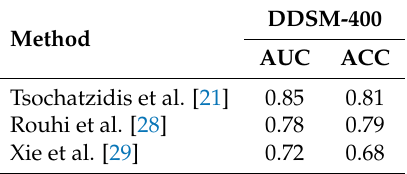
Figure 6. Performance of convolutional neural networks for from-scratch and fine-tuning scenarios in terms of AUC for ( a ) DDSM-400 and ( b ) CBIS-DDSM. Table 4. Performance of state-of-the-art methods based on hand-crafted